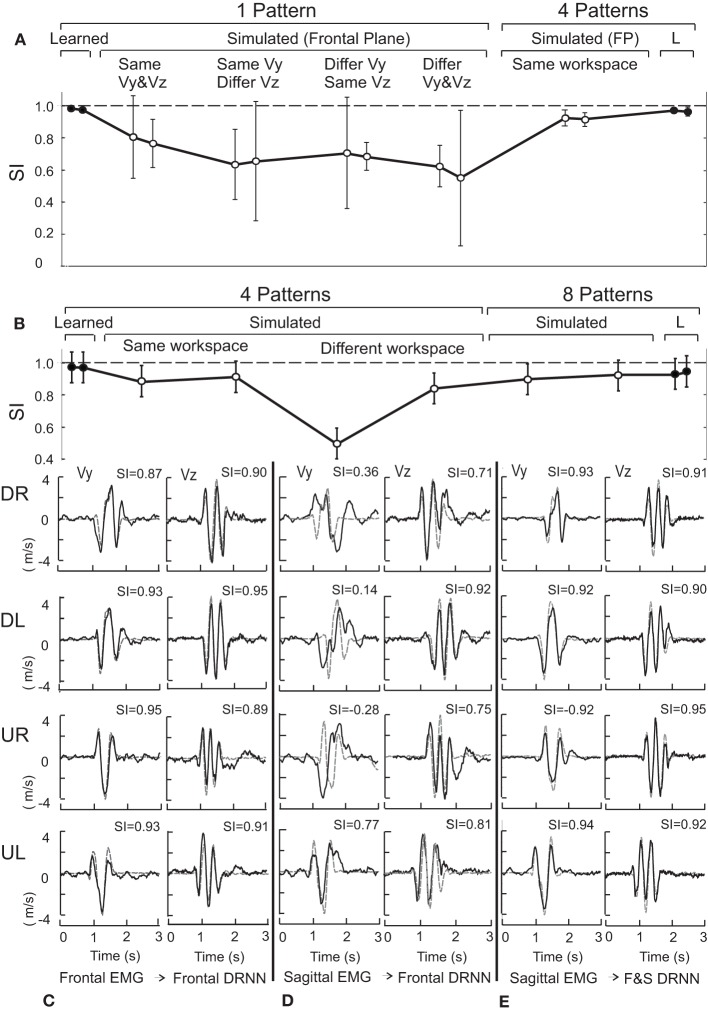
(A) Shows the mean and standard deviation of the similarity index for the same and different movement directions within the frontal plane for 1-pattern DRNN and 4-pattern DRNN trainings. (B) Presents similarity indexes for same and crossed workspaces for 4-pattern DRNN and 8-pattern DRNN trainings. SIs for learned and simulated curves correspond to black and open circles, respectively. (C) Illustrates the simulated and experimental velocity profiles for the four frontal movements (DR: down-right; DL: down-left; UR: up-right; UL: up-left) injected into the frontal DRNN. (D) Shows the simulated velocity profiles from injecting the sagittal EMG patterns into the frontal DRNN. (E) Shows the simulated velocity profiles from injecting the sagittal EMG patterns into the dual DRNN. The similarity indexes are indicated above each profile's graph.